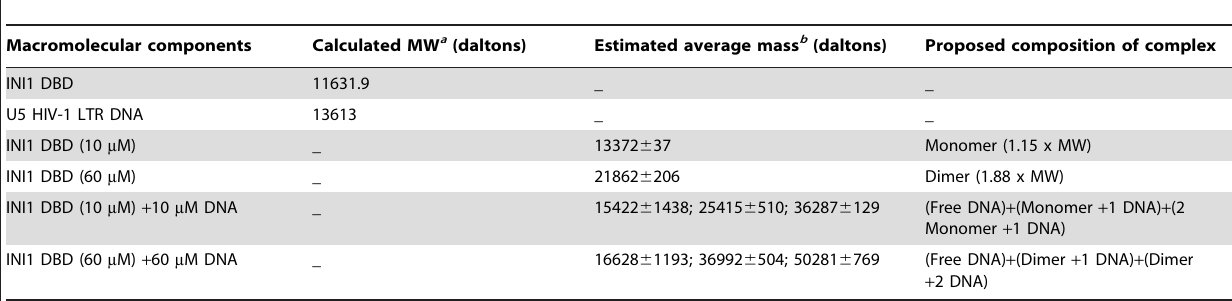
Table 1. Determination of stoichiometries of INI1 DBD binding to U5 HIV-1 LTR DNA from analytical ultracentrifugation